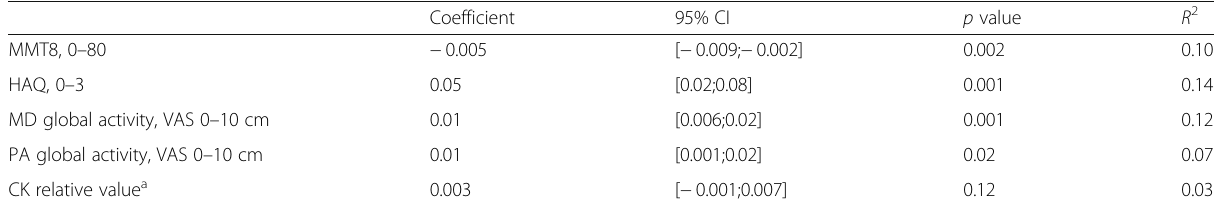
MMT8: each of eight muscle groups scored 0 – 10; lower scores indicate reduced strength. HAQ, MD, and PA global activity: higher scores indicate more severe disease